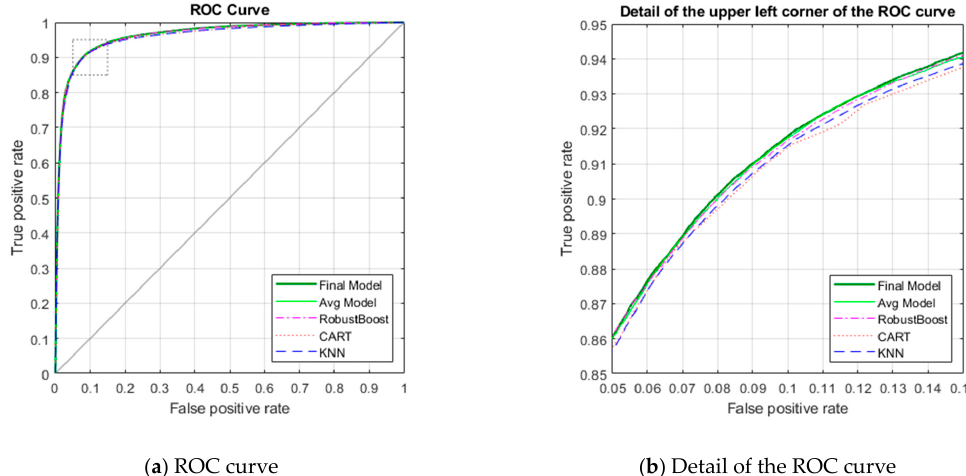
Figure 7. The ROC curve of prediction models in the Visegrad group.